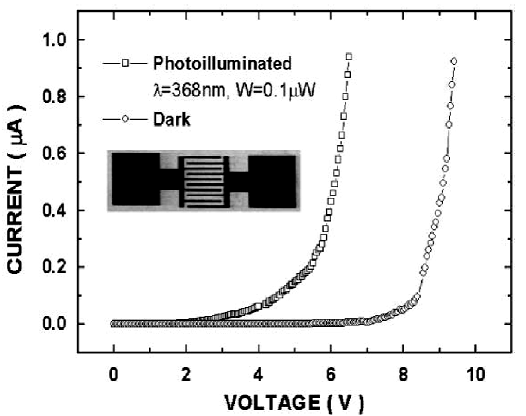
Figure 4. I–V characteristics of a ZnO Schottky photodetector with an interdigital structure. The inset shows a SEM picture of the top view of the device